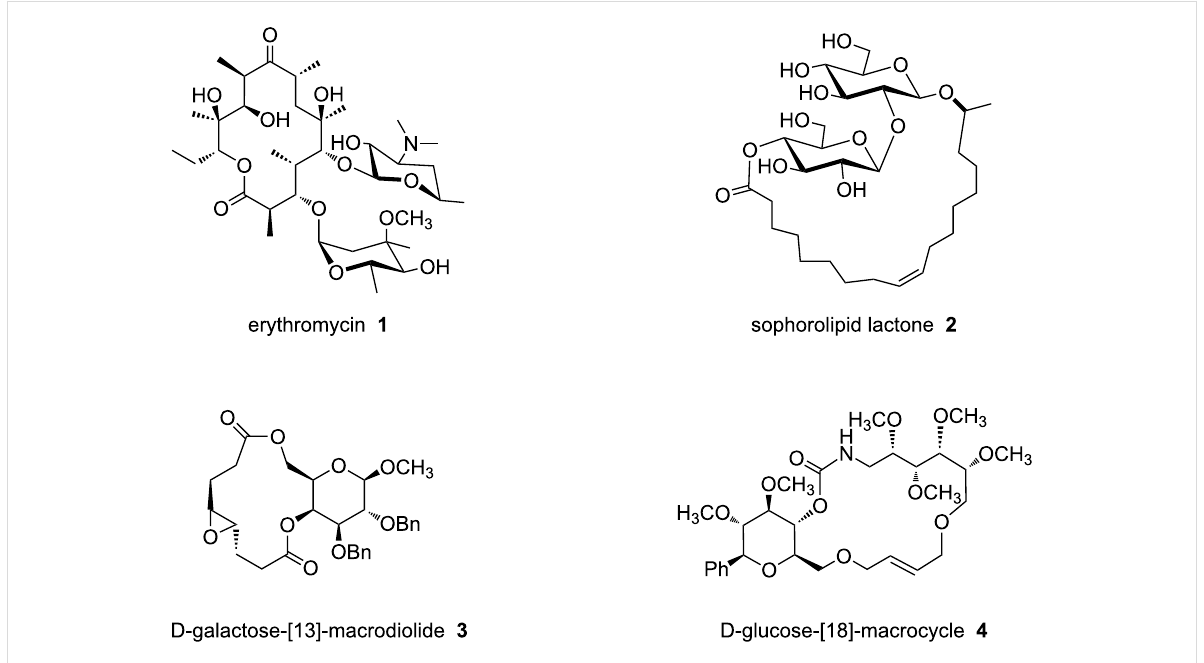
Figure 1: Erythromycin ( 1 ), the archetypal macrolide; sophorlipid lactone 2 , a glycolipid macrolactone; β -D-galactose fused-[13]-macrodiolide 3 and β -D-glucose-fused [18]-macrocycle 4